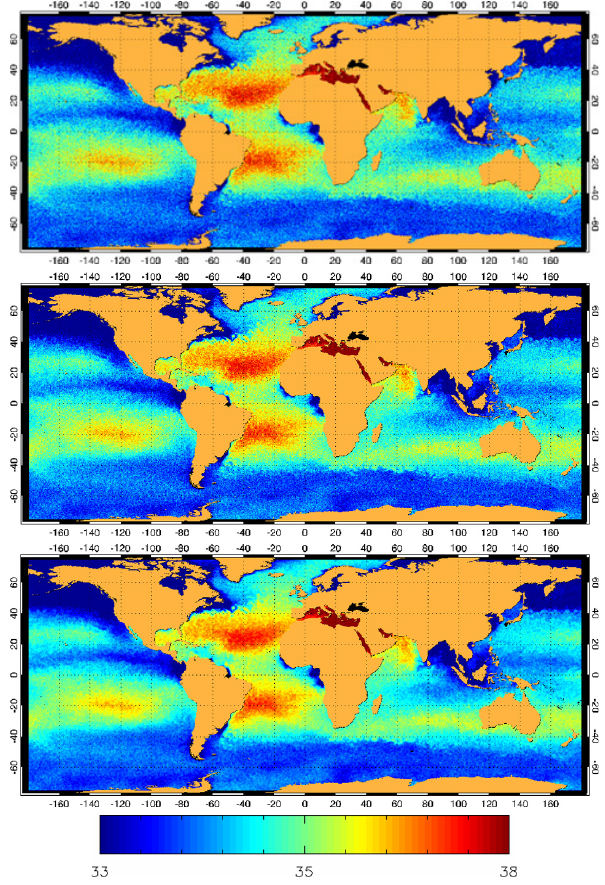
Fig. 14. Results of applying median filters to a noisy salinity with no spatial correlation and amplitude 1 (same as in Fig. 7, top). The filters are calculated over boxes of variable sizes centered around each point. Results are for 3 × 3 boxes (top), 5 × 5 boxes (middle), and 11 × 11